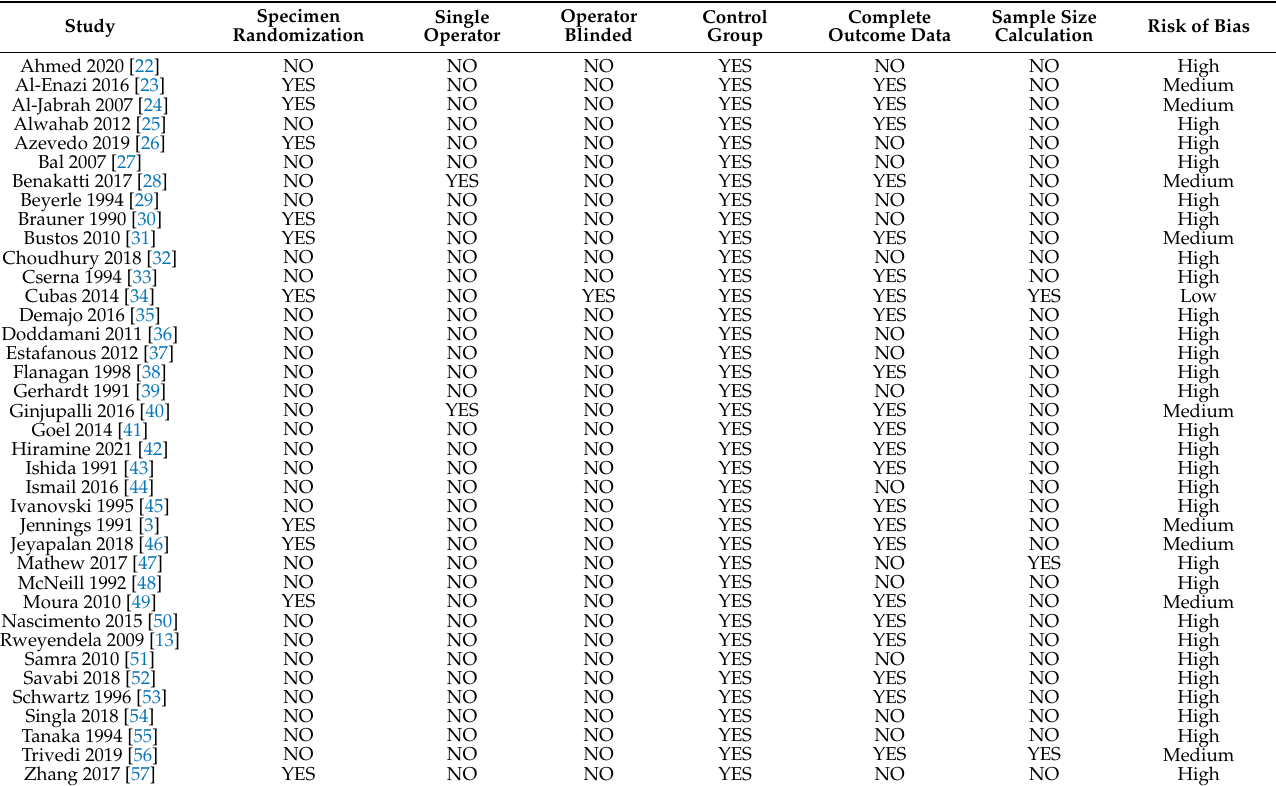
Table 3. The results of the risk of bias assessment.